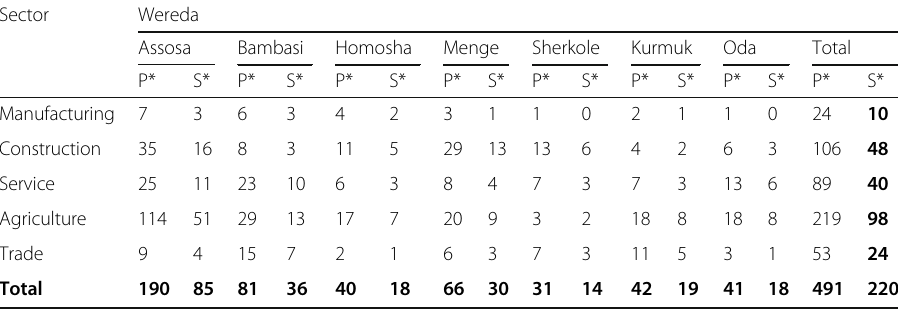
Ratio = 220.427/491 = 0.449 P* population, S*